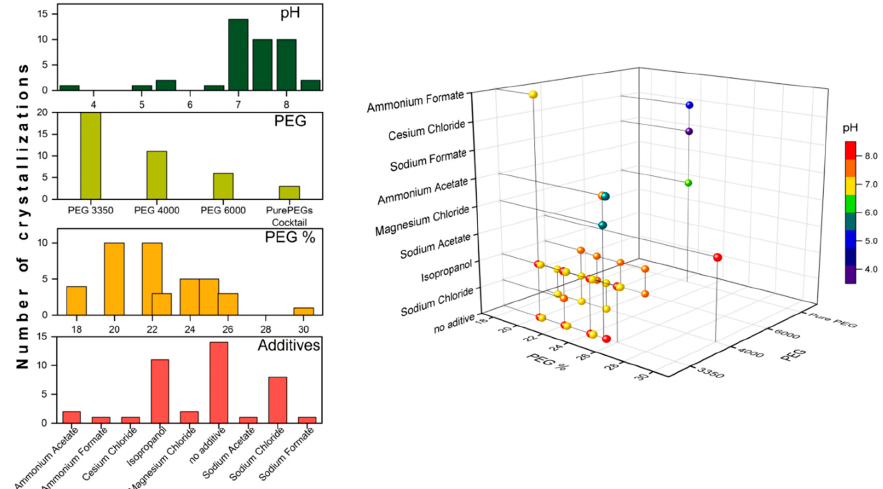
Figure 3. Distribution of the number of successful protein crystallizations of all PEG conditions found in systematic screening as a function of pH, size of the PEG, PEG %, and which additives were included. A 3D graph that displays all of the components of the PEG conditions is shown on the right.